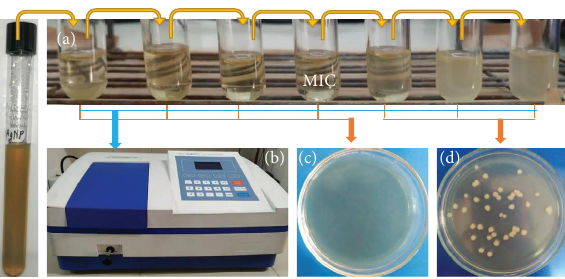
Figure 2: Determination of MIC according to CLSI 2019 where (a) two-fold serial dilution of Ag-NPs, (b) measurement of turbidity using UV-Vis spectroscopy (UV-1600PC), (c) inhibition of bac- terial growth on MH agar, and (d) bacteria growth on MH